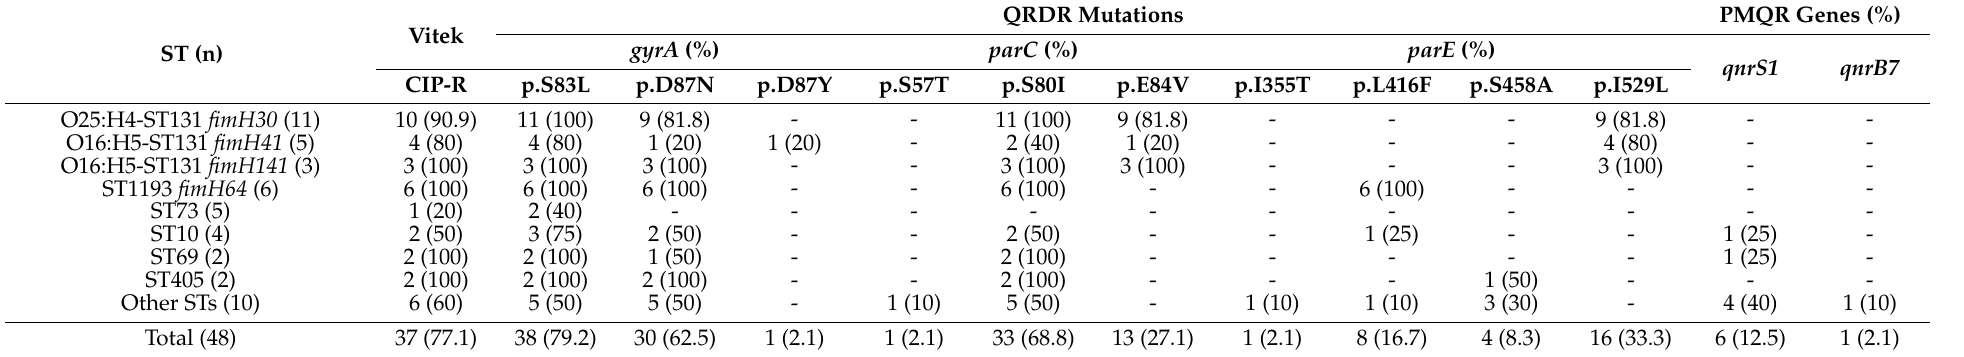
Table 4. Sequence types and prevalence of QRDR mutations and PMQR genes in UPEC isolates from this